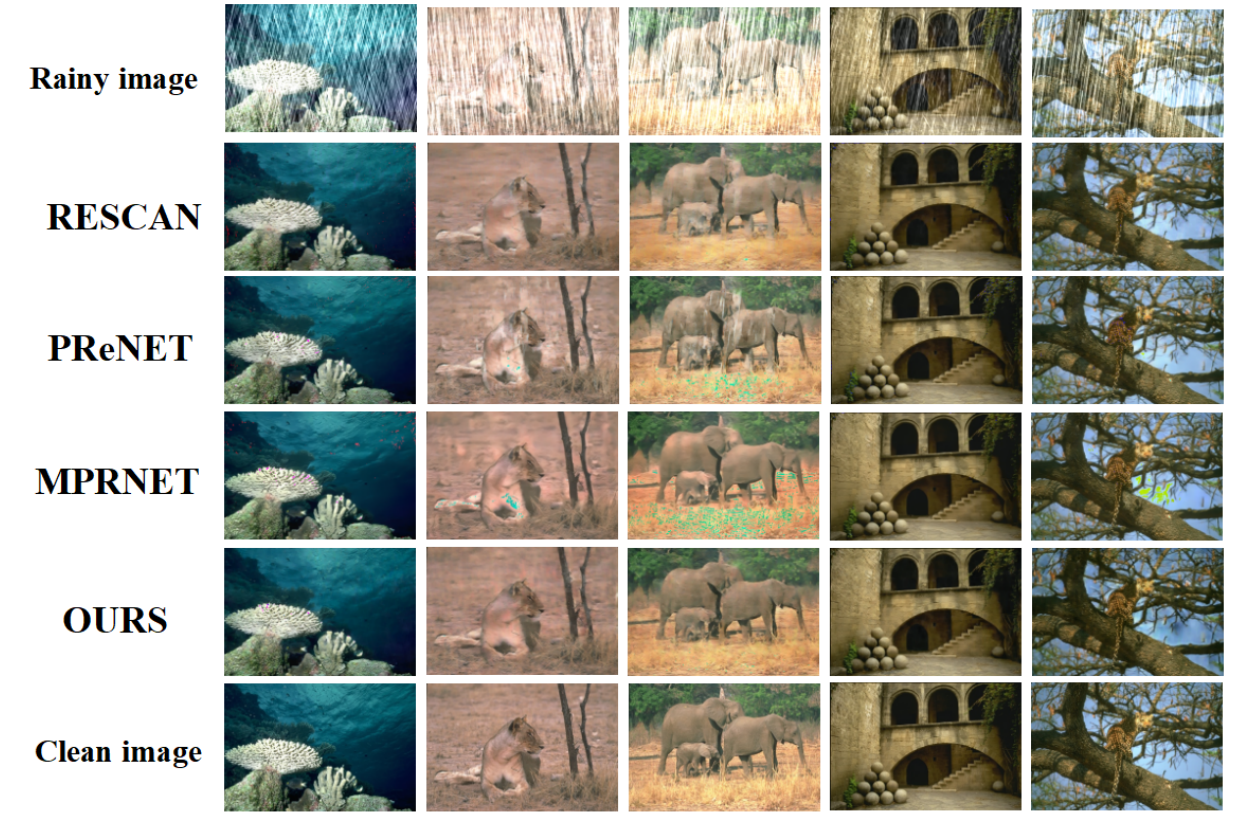
Figure 8. Results of rain images in Rain200H